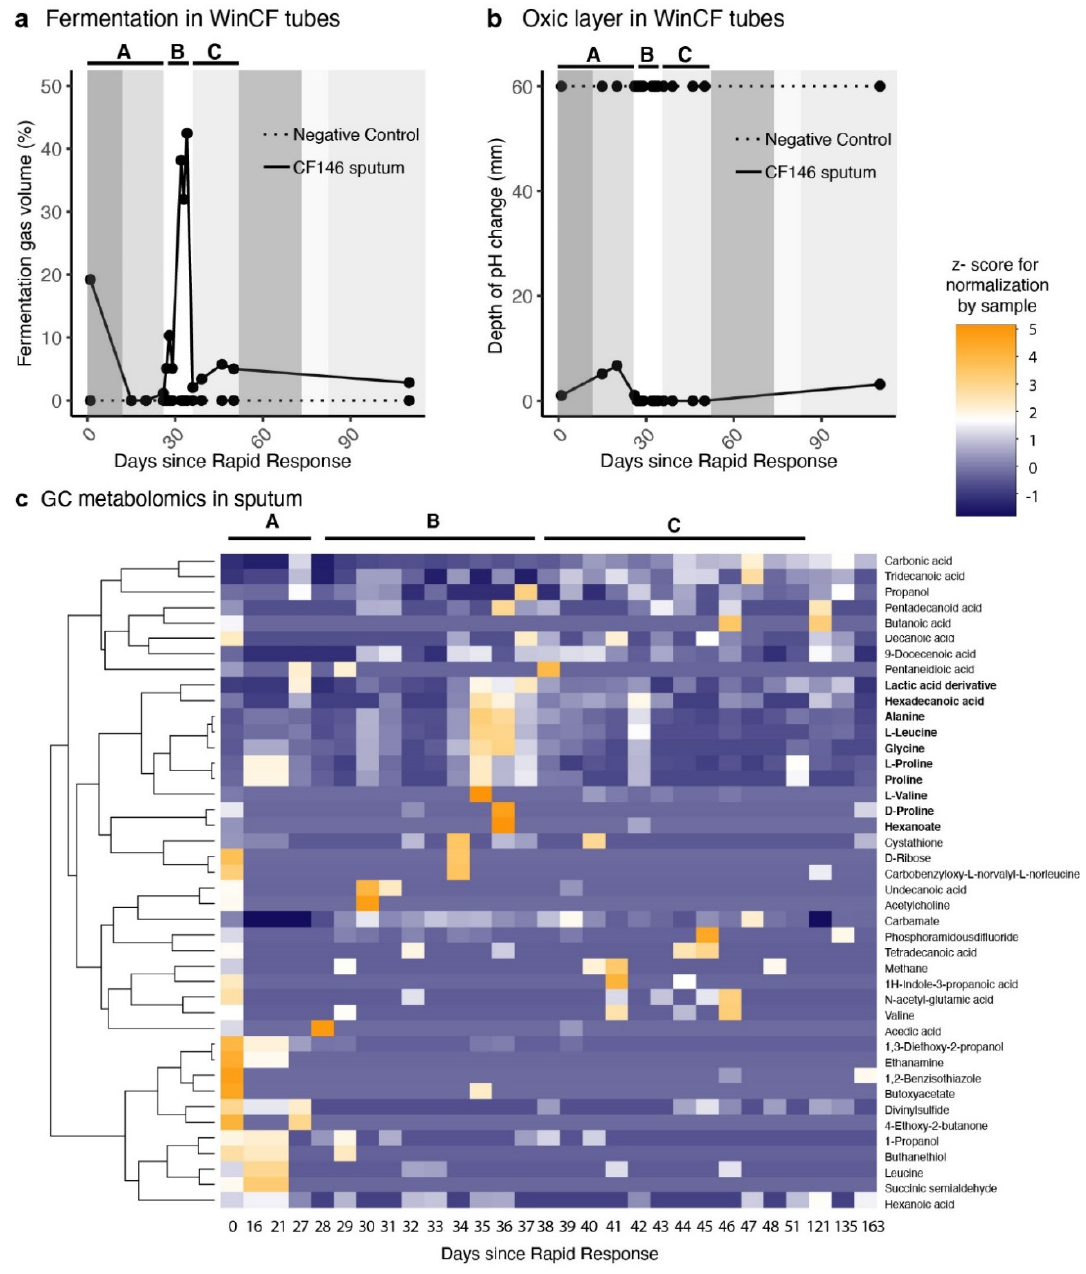
Figure 2. Fermentation in the sputum of patient CF146. ( a ) production of fermentation gas in in WinCF capillary tubes inoculated with sputum microbial communities in artificial sputum media; ( b ) depth of pH change in WinCF capillary tubes. The depth of tube where the pH changes corresponds to the transition from the oxic to anoxic environment and is analogous to the oxygen penetrance in the mucus plugs in the lung [34]. ( c ) Relative abundances of polar molecules identified by GC-MS metabolomic analysis. Abundances were normalized by rows (days) to allow between-sample comparisons and plotted are the z-scores of this normalization. The letters A, B and C within the plot area in the three panels indicate the different antibiotic treatment periods.